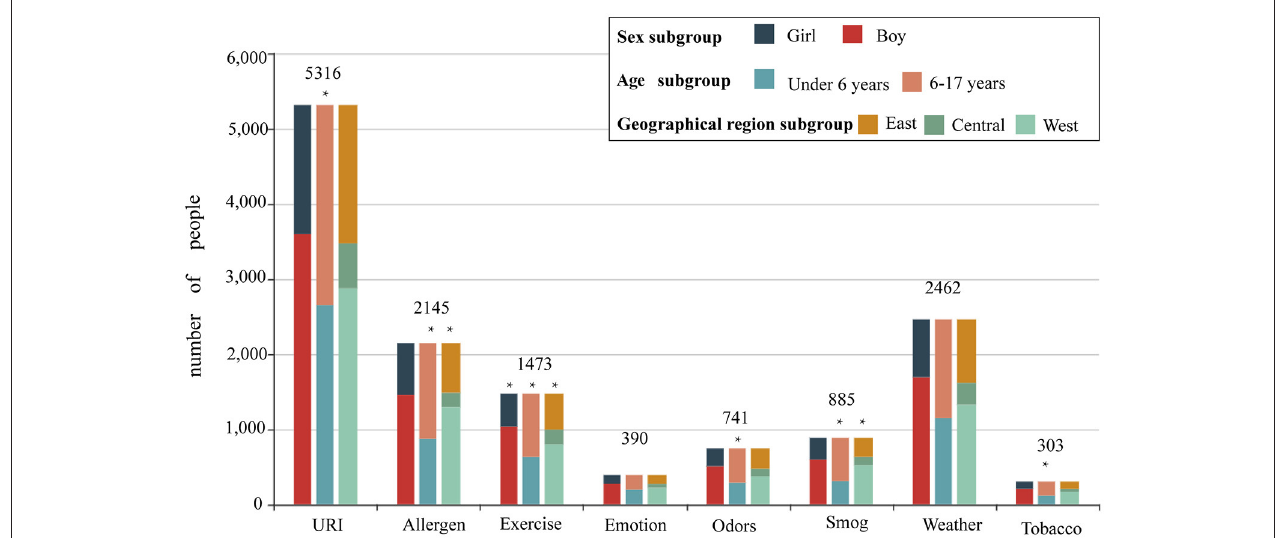
FIGURE 3 | The proportion of different asthma triggers according to sex, age, and geographical distributions. Patients were divided into a boy group and a girl group according to sex; patients were divided into a < 6-year-old group and a 6- to 17-year-old group according to age; and patients were divided into an eastern region group, a central region group, and a western region group according to geographical distributions.